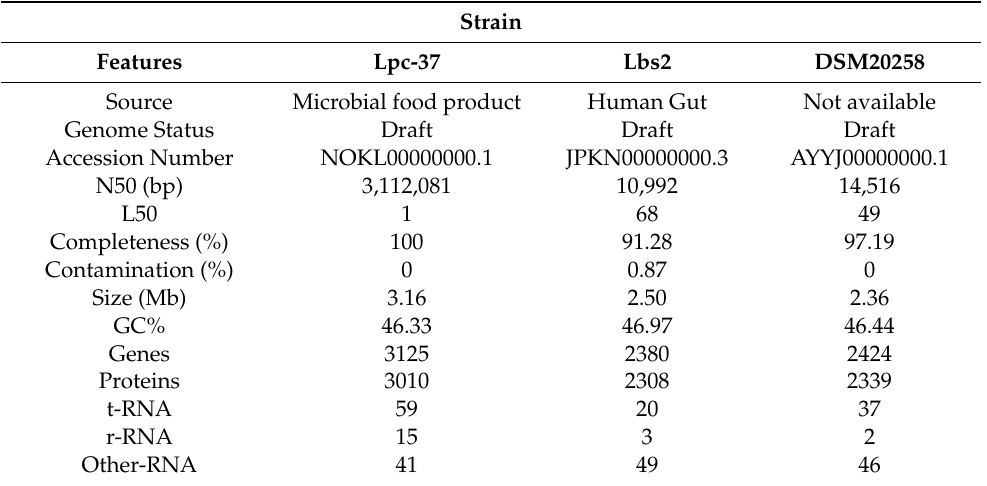
Table 2. Genome assembly statistics of the three Lactobacillus paracasei strains (Lpc-37, Lbs2,